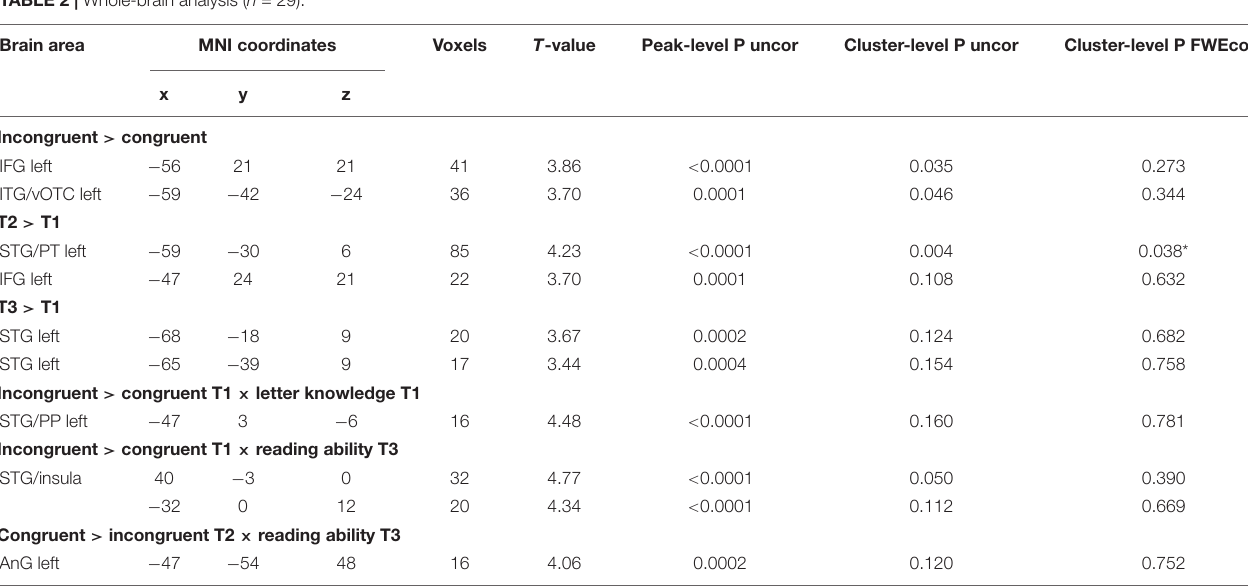
FIGURE 4 | Whole-brain analysis ( n = 29). (A) Incongruency effect: higher activation for incongruent than congruent letter-speech sound pairs in the left inferior frontal gyrus and the left ventral occipitotemporal cortex. (B) Effect of time: stronger audiovisual processing at T2 than T1 in the left inferior frontal gyrus and superior temporal gyrus/planum temporale. (C) Effect of time: activation increase for audiovisual processing in the left superior temporal gyrus is still evident at T3. TABLE 2 | Whole-brain analysis ( n =